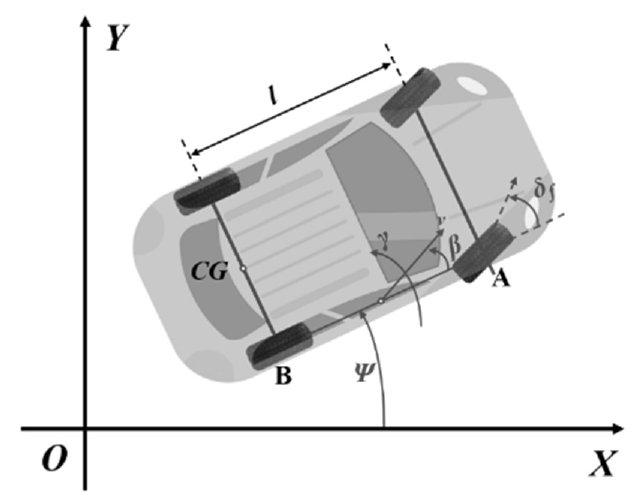
Figure 4. Kinematic model of an autonomous vehicle.